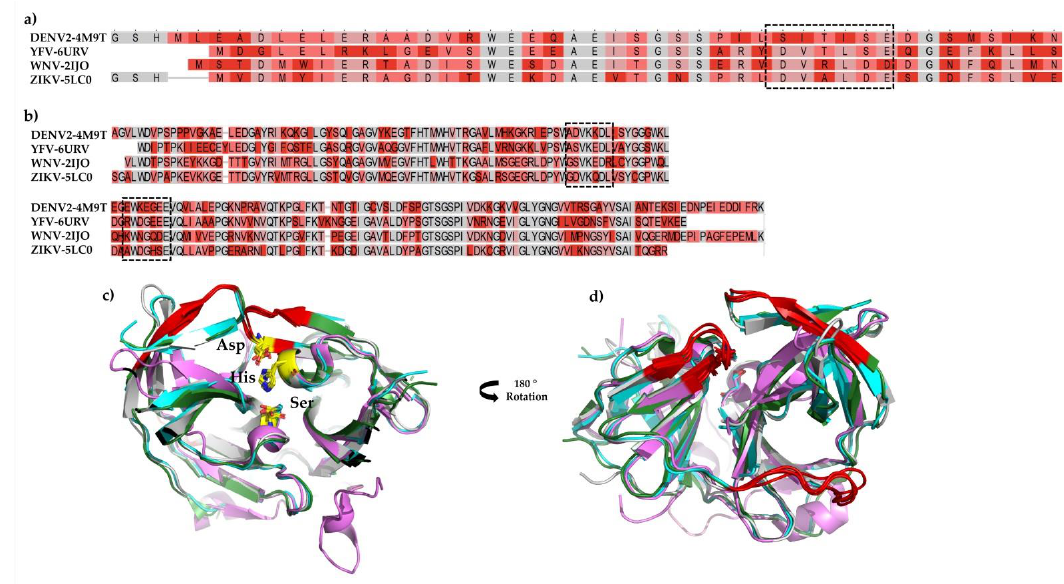
Figure 3. Sequence alignment of the NS2B ( a ) and NS3pro ( b ) of the studied viruses. Structural alignment highlighting the catalytic triad ( c ) and the allosteric binding site ( d ).